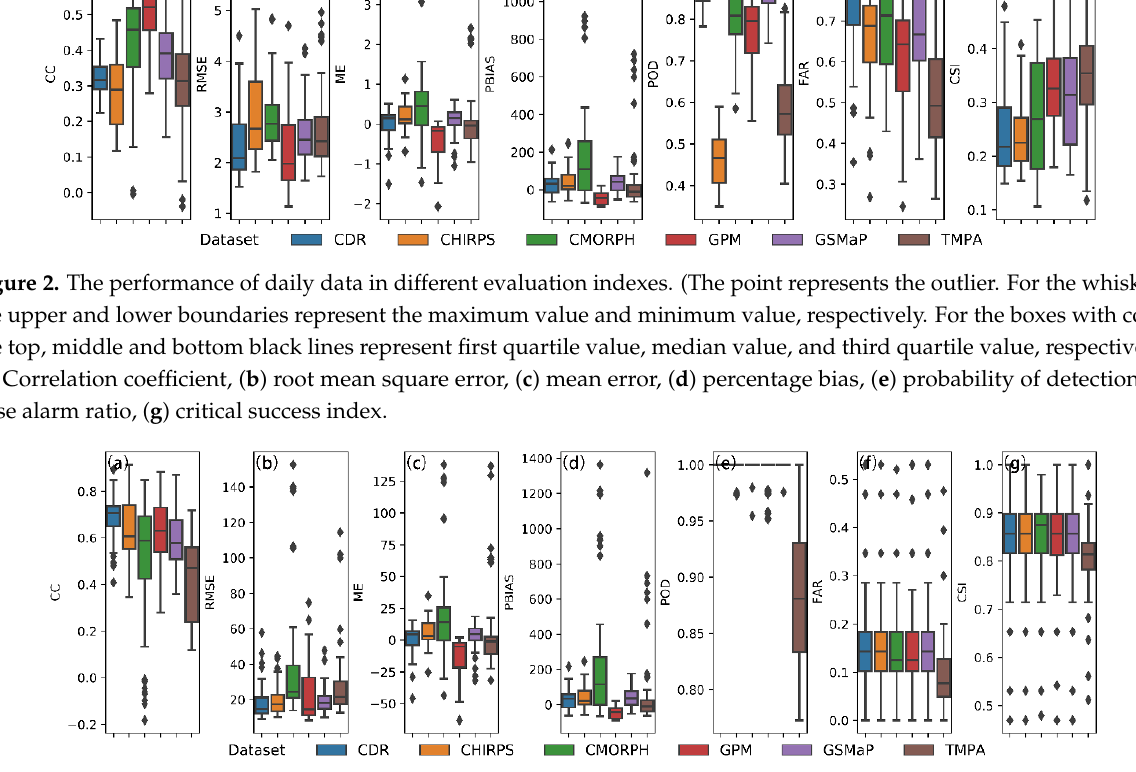
Figure 3. The performance of monthly data in different evaluation indexes. (The point represents the outlier. For the whiskers, the upper and lower boundaries represent the maximum value and minimum values, respectively. For the boxes with color, the top, middle and bottom black lines represent first quartile value, median value, and third quartile value, respectively.) ( a ) Correlation coefficient, ( b ) root mean square error, ( c ) mean error, ( d ) percentage bias, ( e ) probability of detection, ( f ) false alarm ratio, ( g ) critical success index. Table 2. Average evaluation indexes of all station points at both the daily and monthly scale.